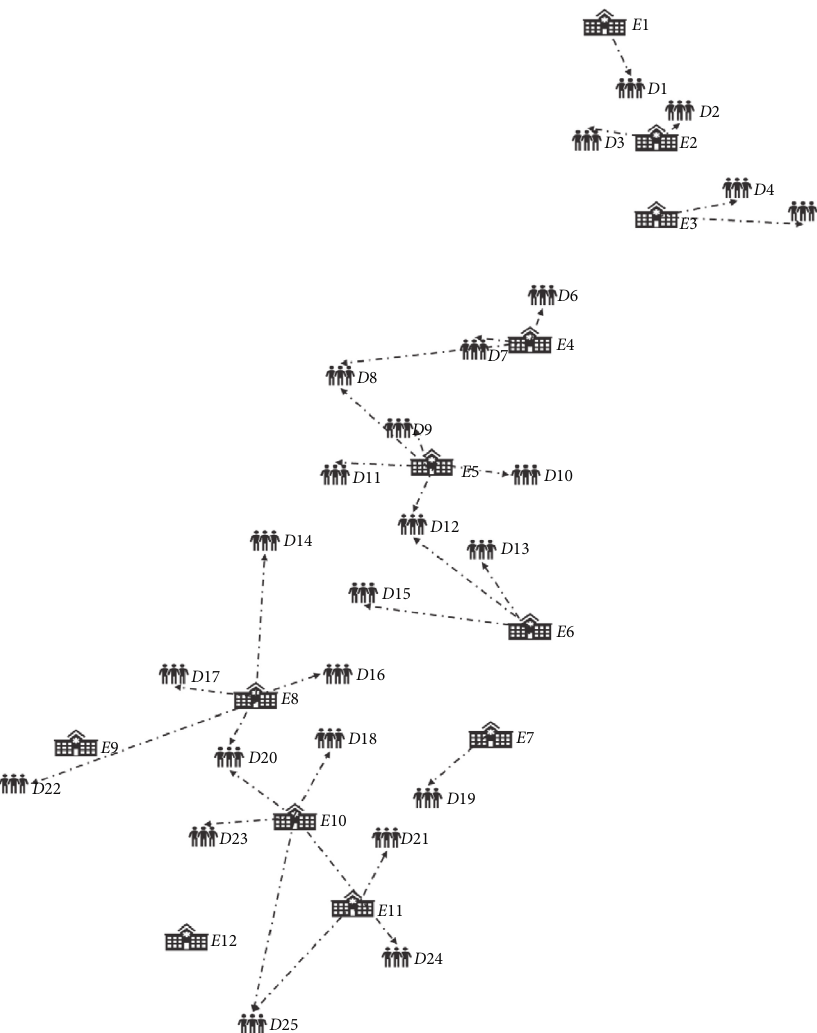
Figure 7: MIRP-polyhedron